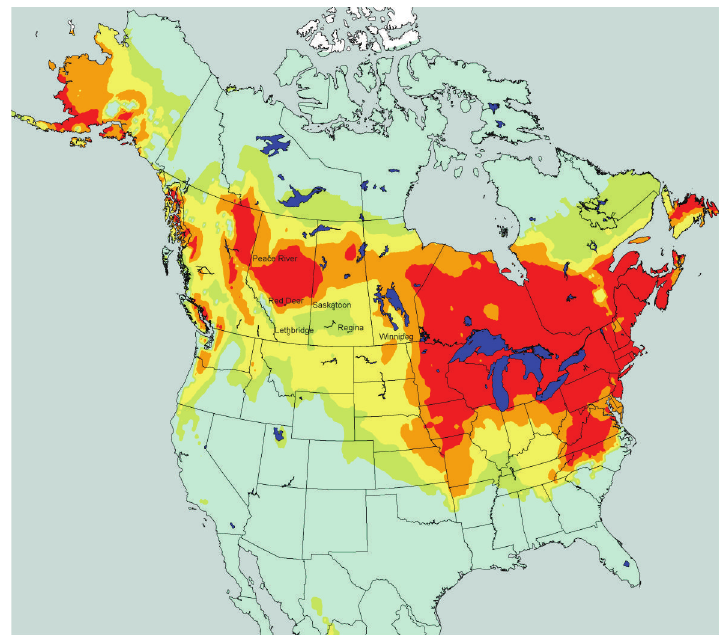
Figure 4: Potential distribution and relative abundance of Sitona lineatus in North America for 2080 as predicted by CLIMEX and the CSIRO Mark 3.0 climate change projection. Dark blue: lakes; Light blue: “Unfavourable” (EI = 0–5); Green: “Marginal” (EI = 5–10); Yellow: “Suitable” (EI = 10–15); Tan: “Favourable” (EI = 15–20); Red: “Very Favourable” (EI > 20).